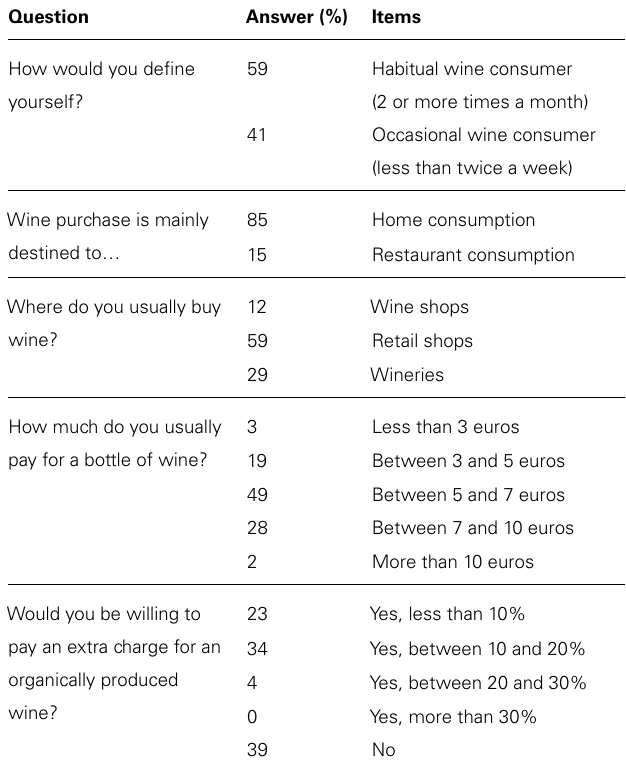
Table 3 | Results from the questionnaire related to wine consumption habit and organic wine purchase